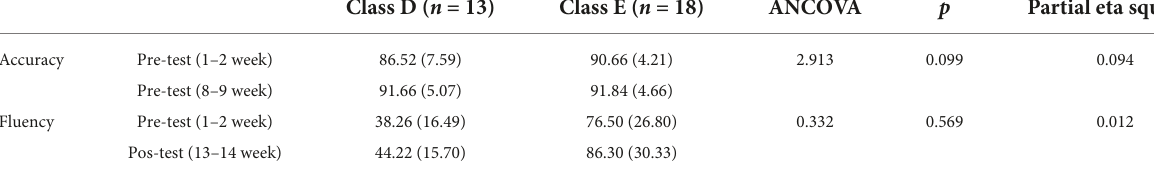
TABLE 6 “No intervention” outcomes.